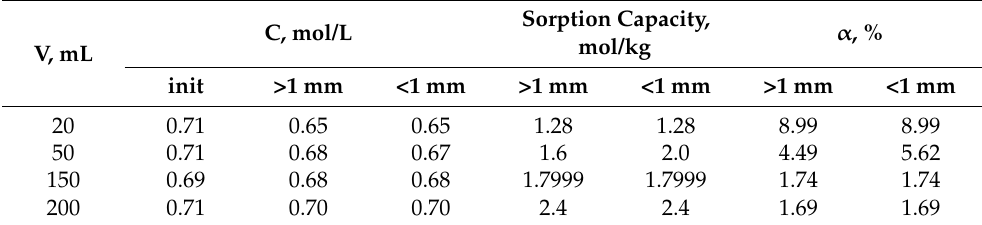
Table 8. Influence of the phase ratio on the sorption extraction of acetone.